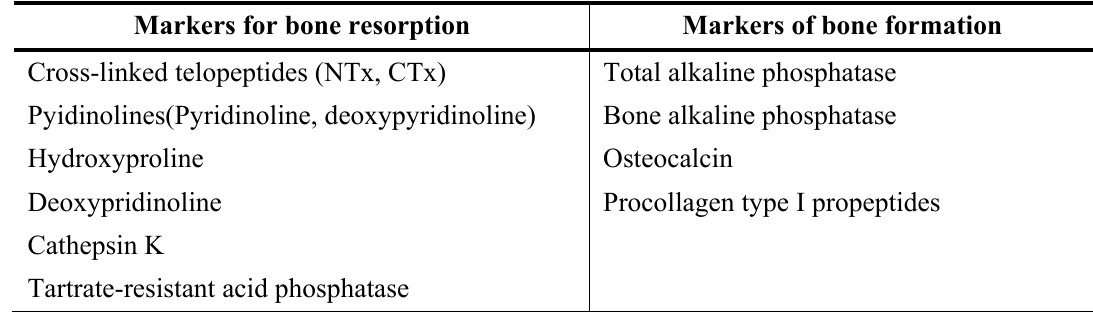
Table 2. List of bone turnover markers that might be used in